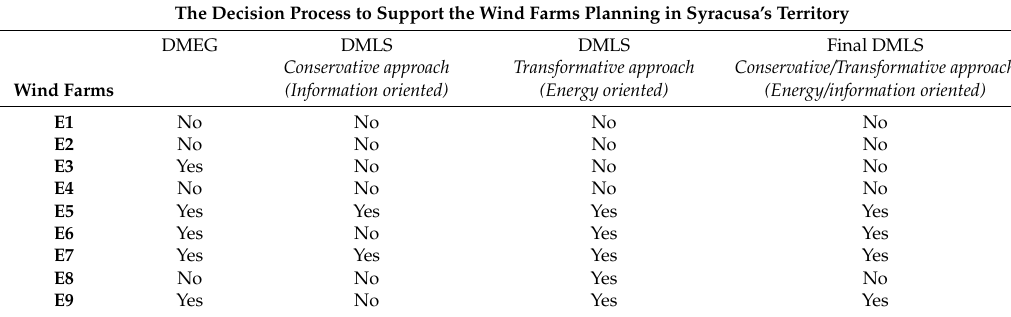
Table 6. Wind farm choices in relation to the three